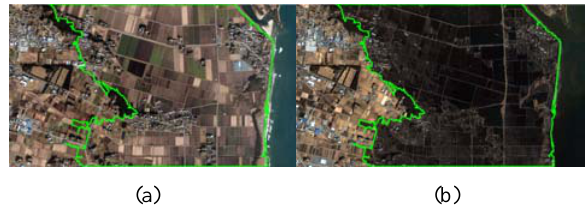
Figure.8 Instance of Extracting Watered Area Swept by Tsunami, (a)Haranomachi in Minamisoma before Tsunami(b)Haranomachi in Minamisoma after